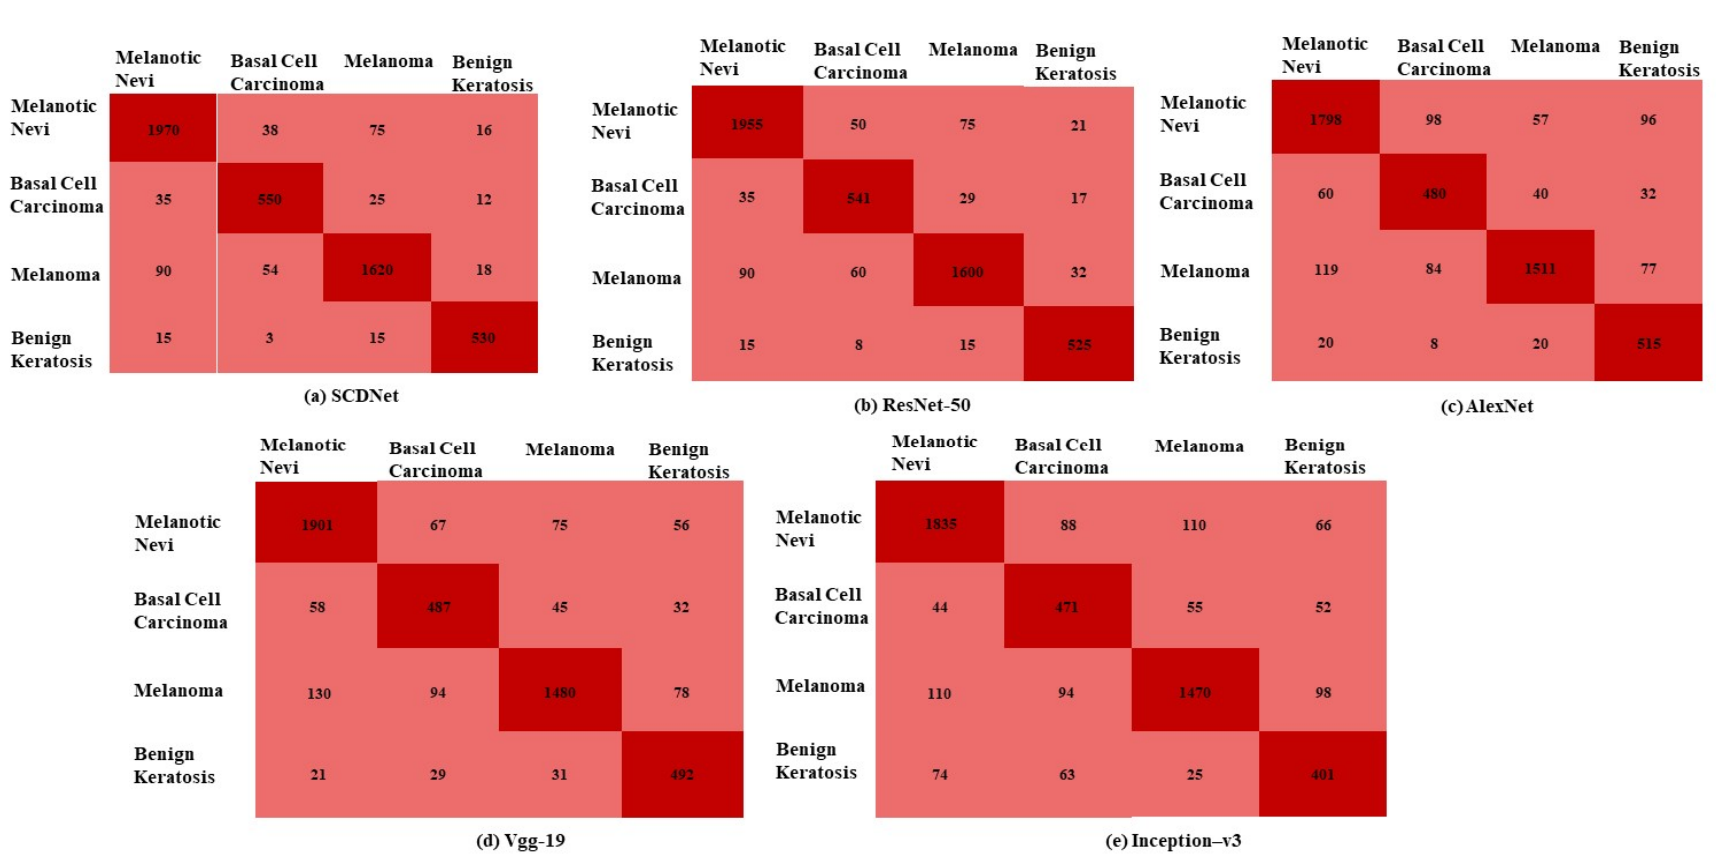
Figure 5. Confusion matrix for ( a ) SCDNet ( b ) Resnet 50 ( c ) Alexnet ( d ) Vgg-19 ( e ) Inception-v3.